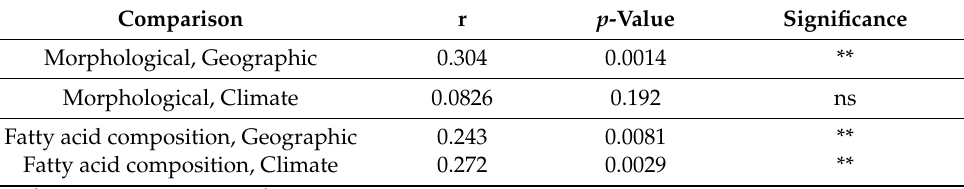
Table 4. Correlations between the morphological parameters (FL, FW) and fatty acid composition (OA, LOA, LNA, PA, SA) of Camellia oleifera with climatic (MAT, MTW, AP, PWQ) and geographic (LON, LAT) distance